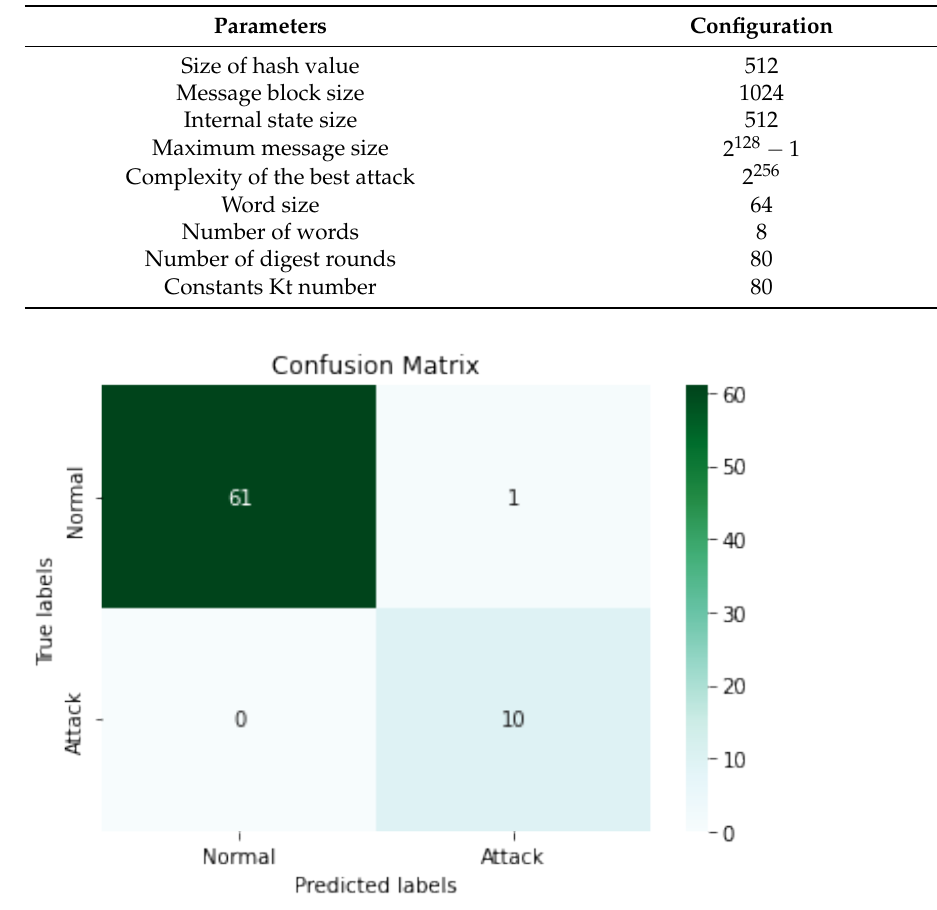
Table 3. Simulation setting.